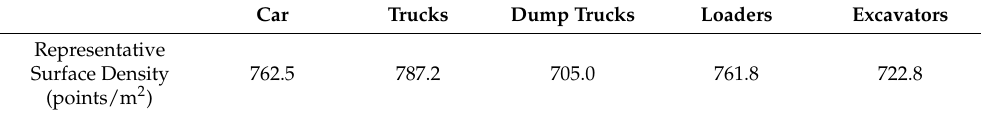
Table 2. Average point density in points per square meter (points/m 2 ) for the training